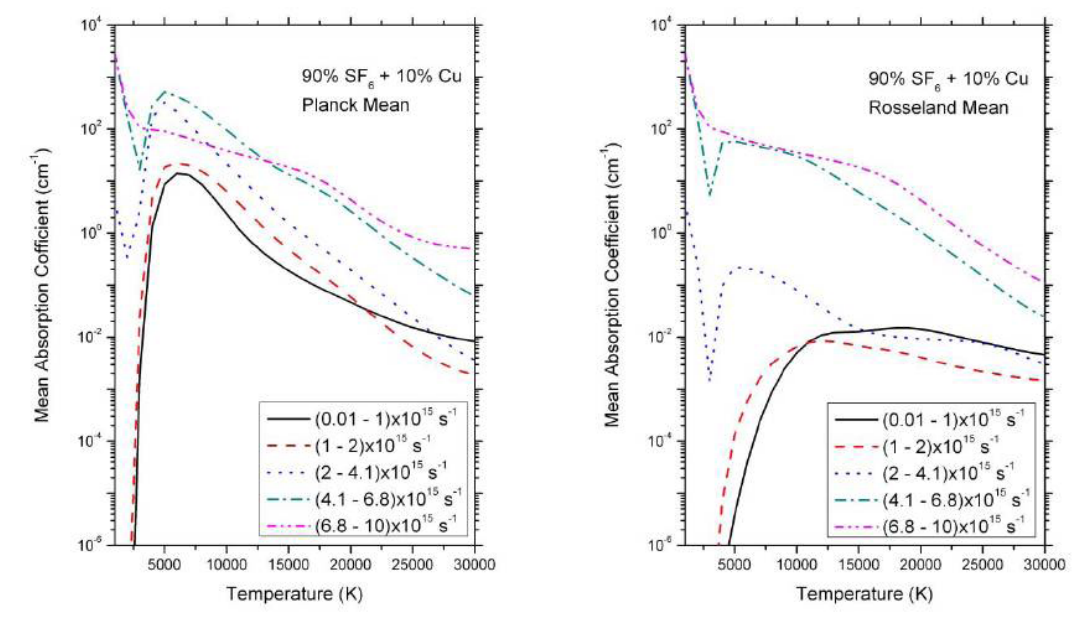
Figure 4: Planck and Rosseland absorption means as a function of temperature for plasma 90% SF